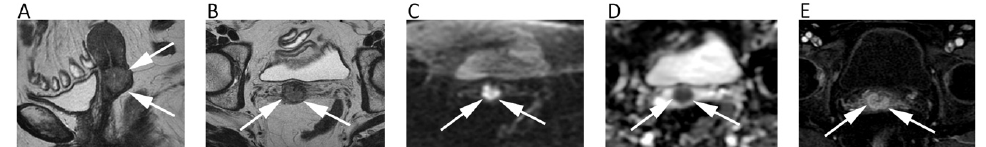
Figure 8. A cervical cancer without parametrial invasion in a 70-year-old woman. The lesion (arrows) is slightly hyperintense compared to normal cervical stroma on sagittal ( A ) and axial ( B ) T2w, whereas it is highly hyperintense on b = 800 DWI ( C ) and hypointense on the corresponding ADC map ( D ), with moderate contrast enhancement on fat-suppressed 3D-GRE T1w ( E